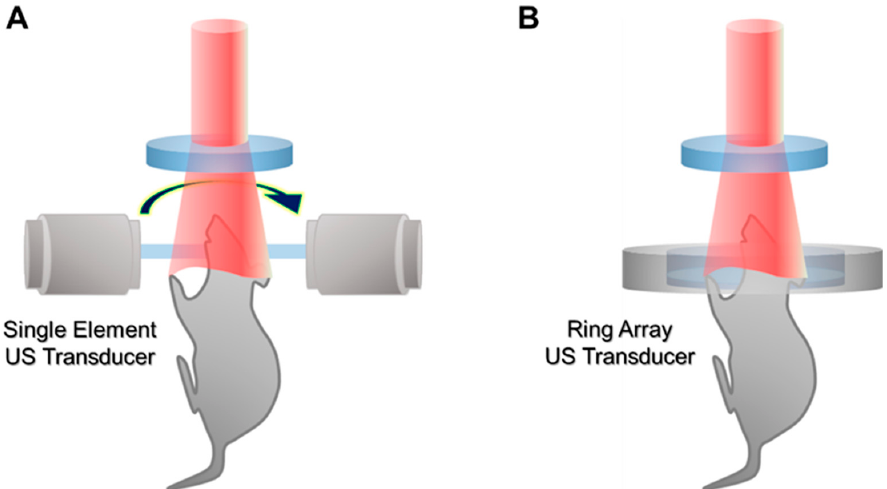
Figure 4. Schematic illustration of PACT. ( A ) PACT with a rotational scanning of a single-element US transducer. ( B ) PACT with a ring array transducer. PACT, photoacoustic computed tomography; US, ultrasound.